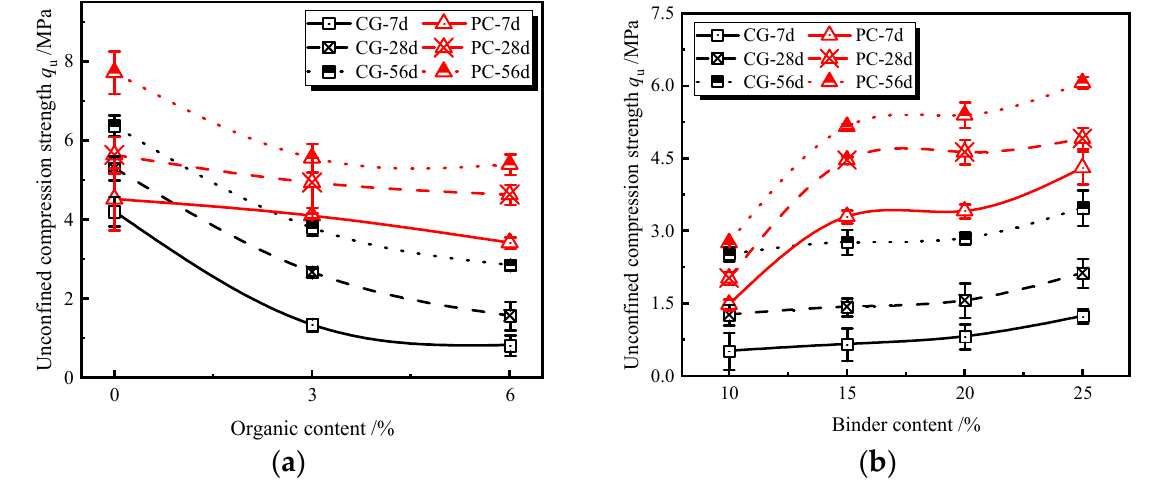
Figure 3. Unconfined compressive strength of CG/PC-stabilized specimens under different condi- tions. ( a ) Influence of organic content. ( b ) Influence of binder